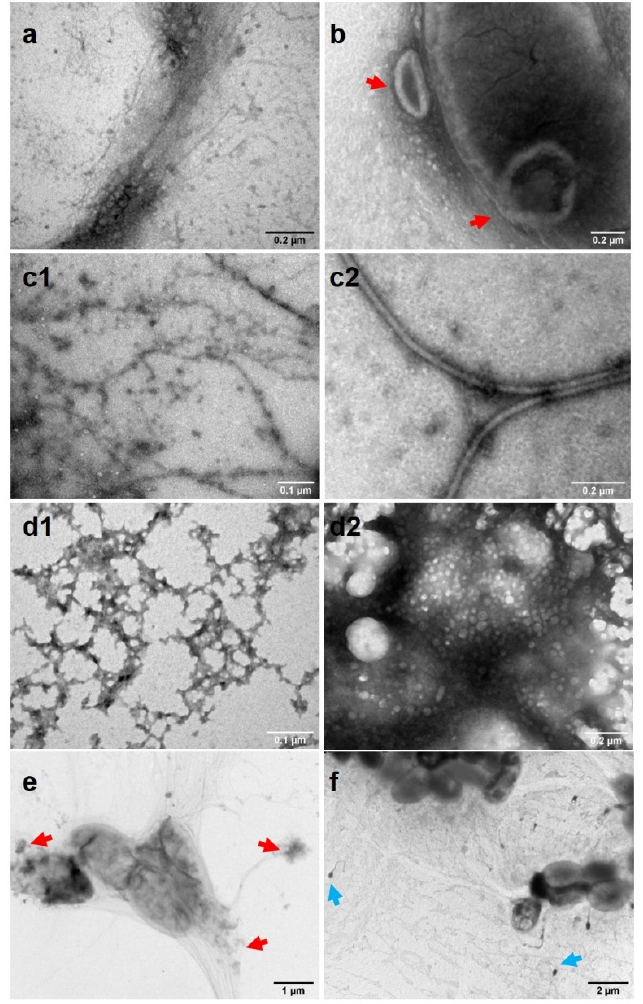
Figure 6. Structures recorded by TEM at planktonic stage and during CITA 33 biofilm progress. Putative vesicles ( a ), membranes ( b ), fibers feature ( c1 , c2 ), EPS feature ( d1 , d2 ), broken cells ( e ) and putative phages ( f ).